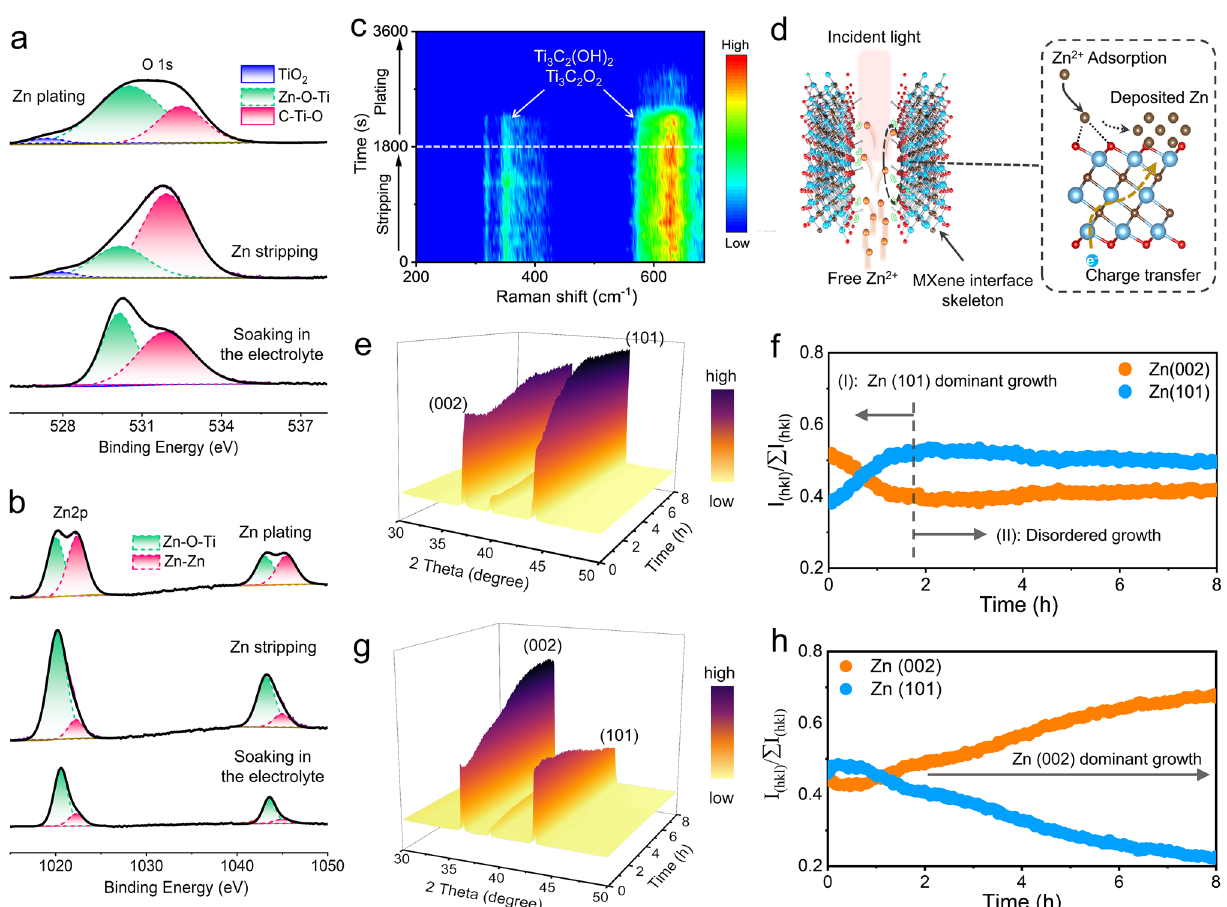
Fig. 5 XPS spectra of a O 1 s and b Zn 2 p of 3D MXene array@Zn anode before and after Zn stripping, and then subsequent Zn planting at 0.5 mA cm −2 . c In-situ Raman pattern of 3D MXene array@Zn anode during Zn stripping/planting process at 0.5 mA cm −2 . d Schematic dia- gram of Zn 2+ adsorption and deposition on the Ti 3 C 2 T x MXene skeleton during the Raman detection process. In-situ 3D XRD isoline pattern and corresponding proportion changes of (002) and (101) crystal plane for e–f pure Zn and g–h 3D MXene array@Zn